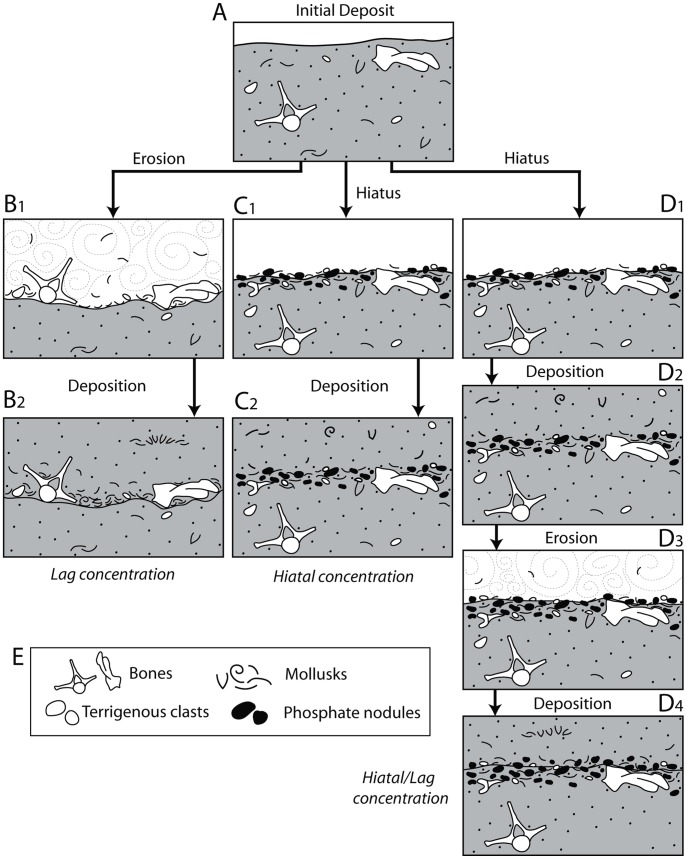
Diagram showing simplified hypotheses of bonebed formation.A) Initial deposit. B1) An erosional event (negative sedimentation) reworks bioclasts and other debris onto an erosional surface, and subsequently buried (B2), resulting in a lag bonebed or concentration. C1) A decrease in sedimentation rate results in a hiatal concentration without a clear erosional surface and a return to ‘normal’ sedimentation buries the assemblage (C2), resulting in a hiatal bonebed or concentration. D1) A hybrid lag/hiatal concentration can be formed, with alternating periods of low sedimentation (D2) and erosion (D3) resulting in a hiatal concentration associated with an erosional lag (D4).